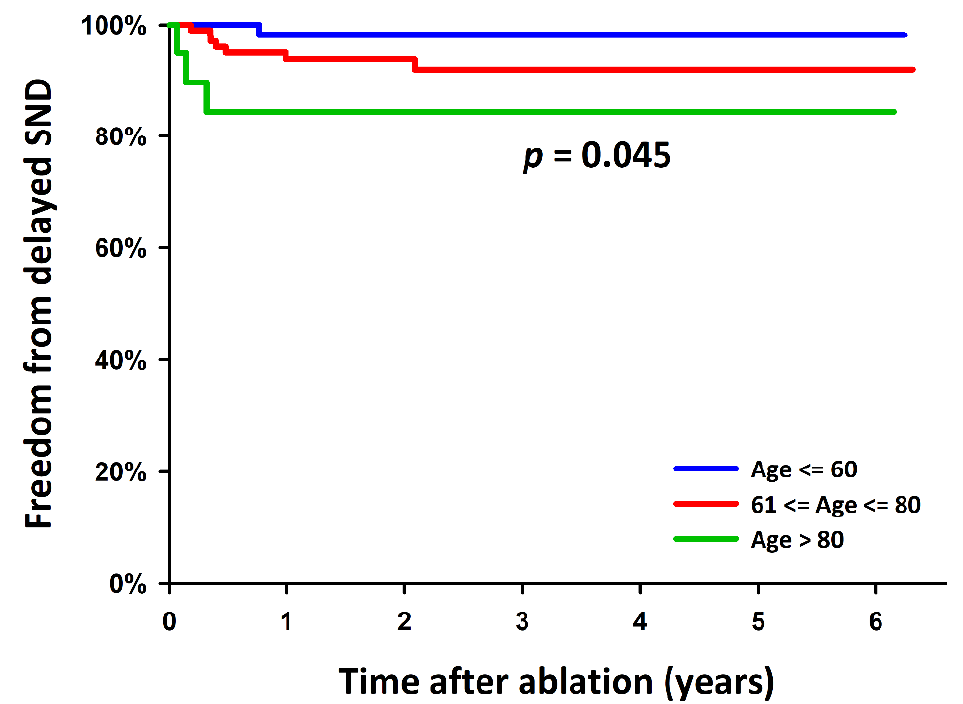
Figure 3. Kaplan–Meier estimates for the delayed SND requiring a PPM after ablation for persistent AFL among patients in the different age groups, with the statistical significance examined using the Log-rank test. AFL: atrial flutter; PPM: permanent pacemaker; SND: sinus node dysfunction.